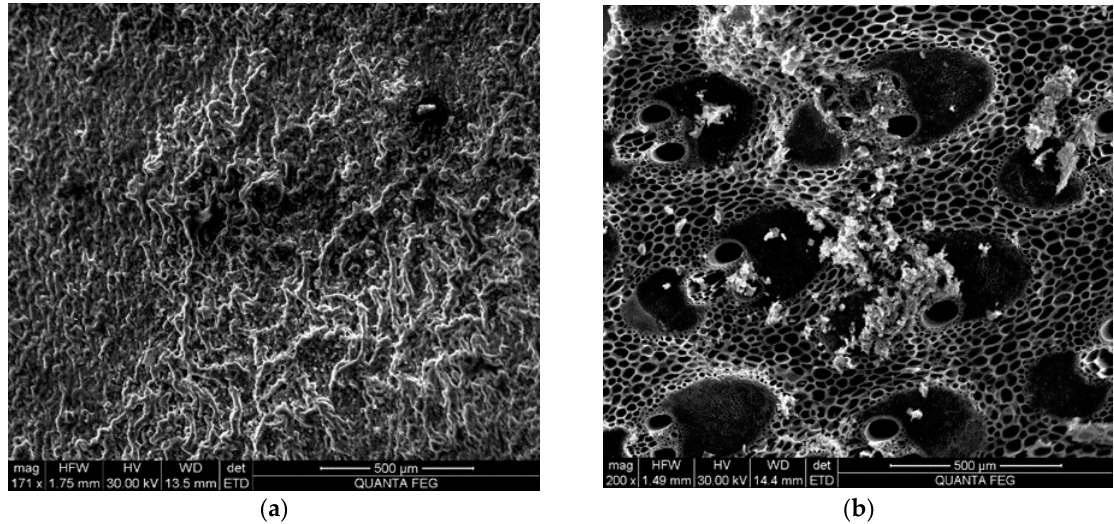
Figure 2. SEM images of bamboo charcoal anode: ( a ) external surface; ( b ) cross section.